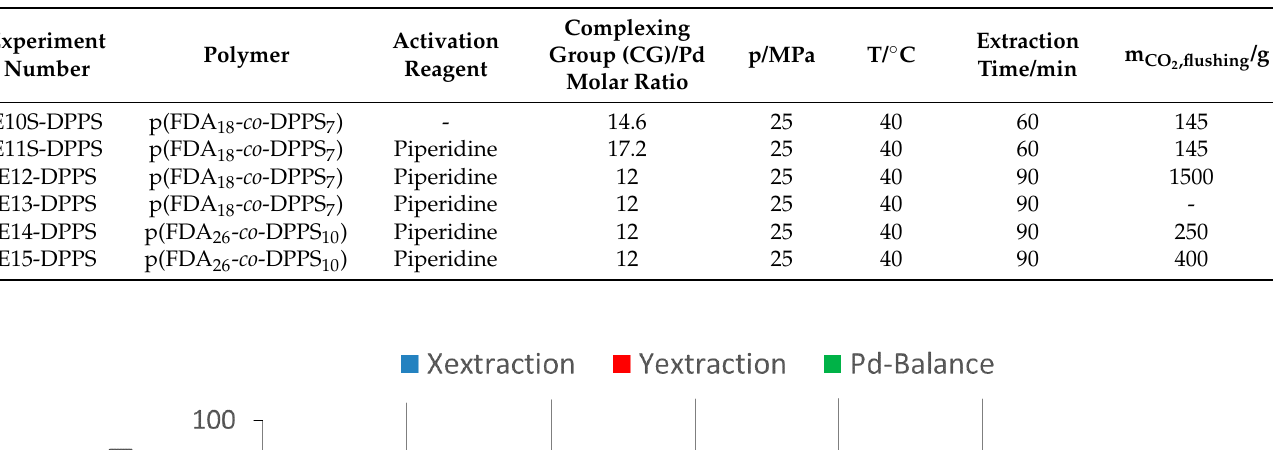
Table 4. Extraction parameters for extractions performed with polymer p(FDA- co -DPPS) (ExS-DPPS: Screening experiments; Ex-DPPS: Detailed investigation experiments).